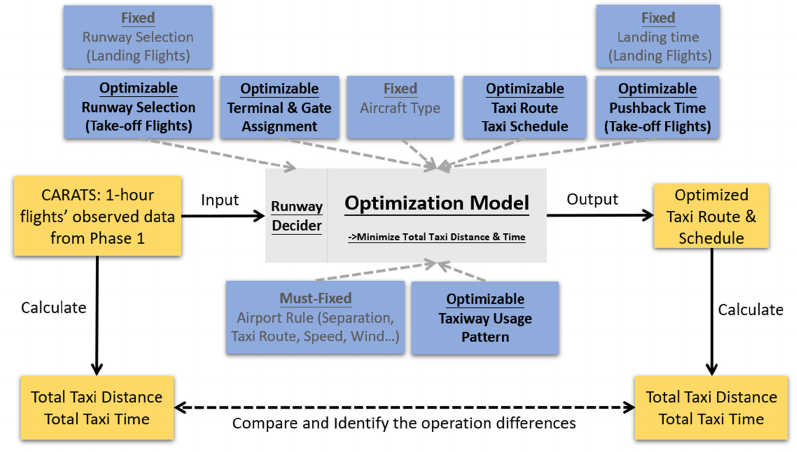
Figure 8. Model implementation and analysis flow.